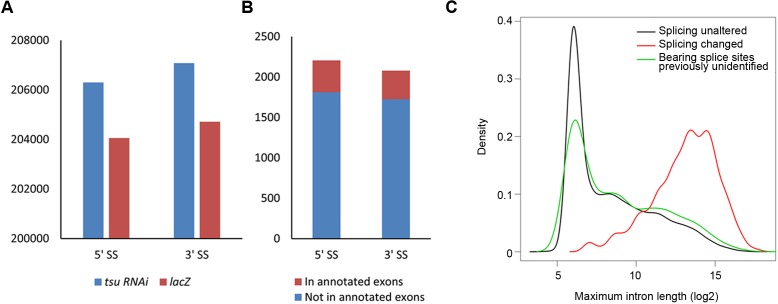
The pre-EJC regulates the alternative splicing.(A) The previously identified 5’ splice sites (SS) and 3’ SS extracted from reference (BDGP v5.78) were used 206,299 and 207,082 times in the tsu sample, respectively, while those used in the lacZ sample were 204,053 and 204,713 times. Thus, compared with the lacZ sample, the tsu sample has a 1.4% (2246/204,053) higher usage for previously identified 5’SS and a 1.5% (2269/204,713) for 3’SS, respectively. p-value for 5' splice site usage is 0.079, and 0.057 for 3’ splice sites (Student’s t-test). (B) Previously unidentified splice sites were detected in RNA-seq when the pre-EJC was knocked down. In total, 2,207 of 5’ SS and 2,081 of 3’ SS were identified, among which 394 of 5’ SS and 395 of 3’ SS were located in annotated exons in reference (BDGP v5.78), respectively. (C) Distribution plot highlights the correlation between maximum intron length and genes whose splicing were subject to differential regulation by the pre-EJC. Shown are distribution plots of genes whose splicing pattern was neither affected (black line) nor changed (red line) by reduced pre-EJC activity. The genes with altered splicing have an overall larger maximum intron length (average length>1000 nt). This result is consistent with previous reports (Ashton-Beaucage et al., 2010; Roignant and Treisman, 2010). In addition, a new class of genes was identified in which previously unidentified splice sites were utilized for generating novel transcripts (green line). Interestingly, no correlation with overall larger maximum intron length was detected in this new class of genes (green lines), implying an unknown mechanism for the pre-EJC to recognize splice sites.